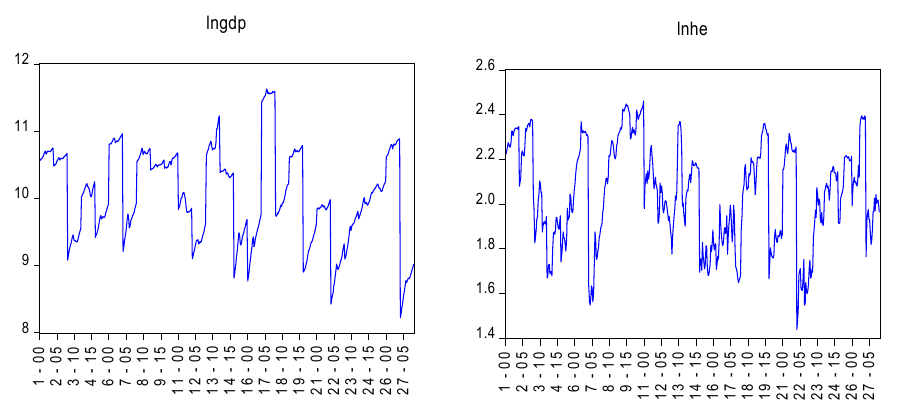
Figure 1. Time Dynamics of Variables.